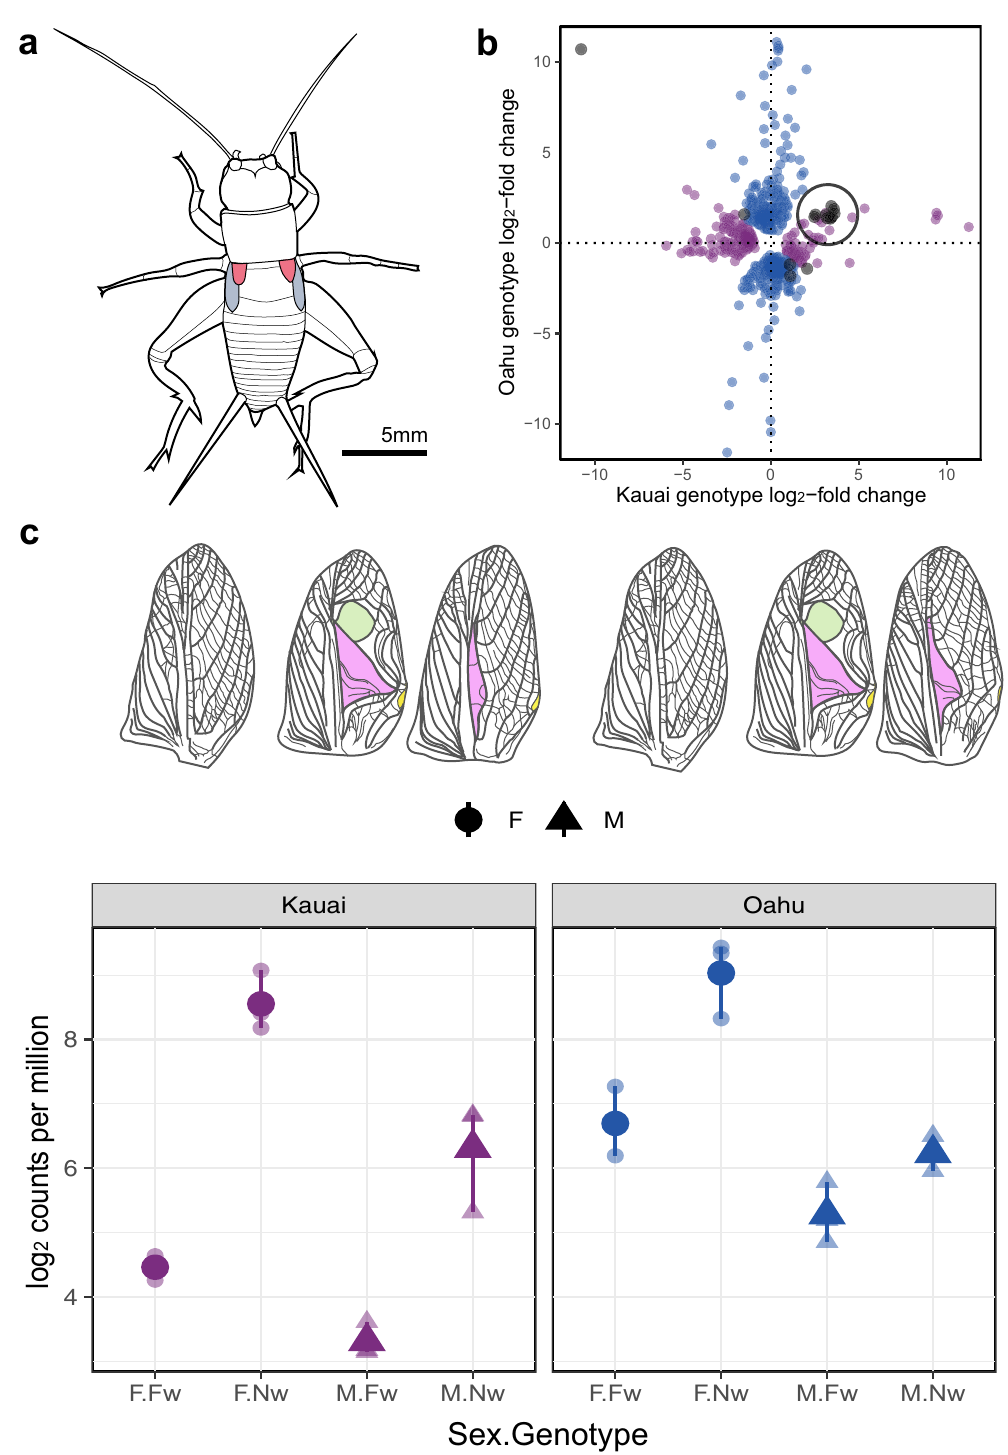
Fig. 5 Differential gene expression analysis of developing male forewings. a Diagram of the penultimate nymphal instar from which right dorsal forewing buds were sampled. Forewings are highlighted in red, hindwings in blue. Diagram drawn by JG Rayner. b The majority of transcripts identi fi ed as differentially expressed between normal-wing and fl atwing genotypes in Kauai (purple) and Oahu (blue) were non-overlapping, with the exception of 15 transcripts identi fi ed in black. Ten of the latter showed coordinated changes in expression (highlighted with a circle). Log 2 -fold changes > 0 on either axis indicate normal-wing biased expression. c Top panel: diagrams of forewing phenotypes for female, fl atwing and normal-wing males from Kauai and Oahu 23 . Flatwing males ’ wings are feminised to different degrees in Kauai vs. Oahu, but female forewings do not noticeably differ between genotypes. Bottom panel: corresponding patterns of relative expression of doublesex in females and males from each population. Large points show means, small points show individual observations for each replicate, and lines indicate the minimum and maximum values. Source data are provided as a Source Data fi le. Diagram is drawn by JG